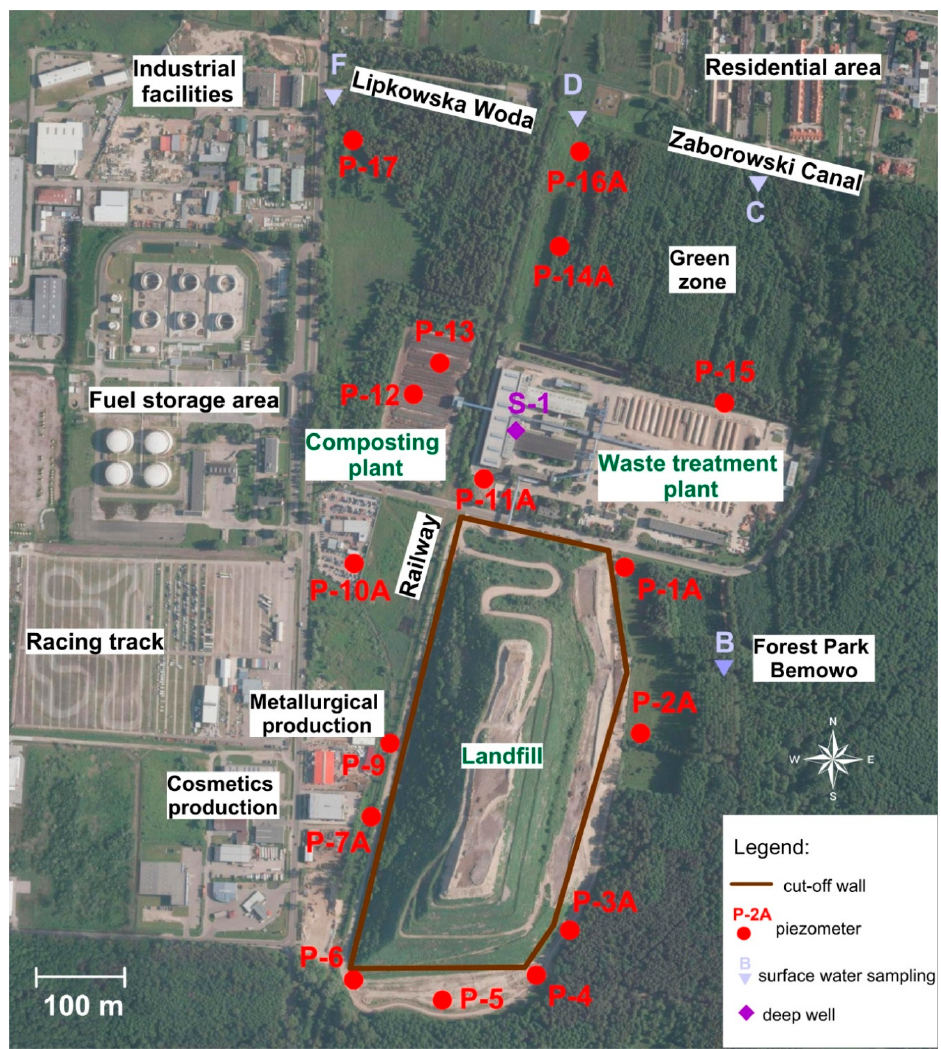
Figure 2. Location of the groundwater monitoring network in the study area.